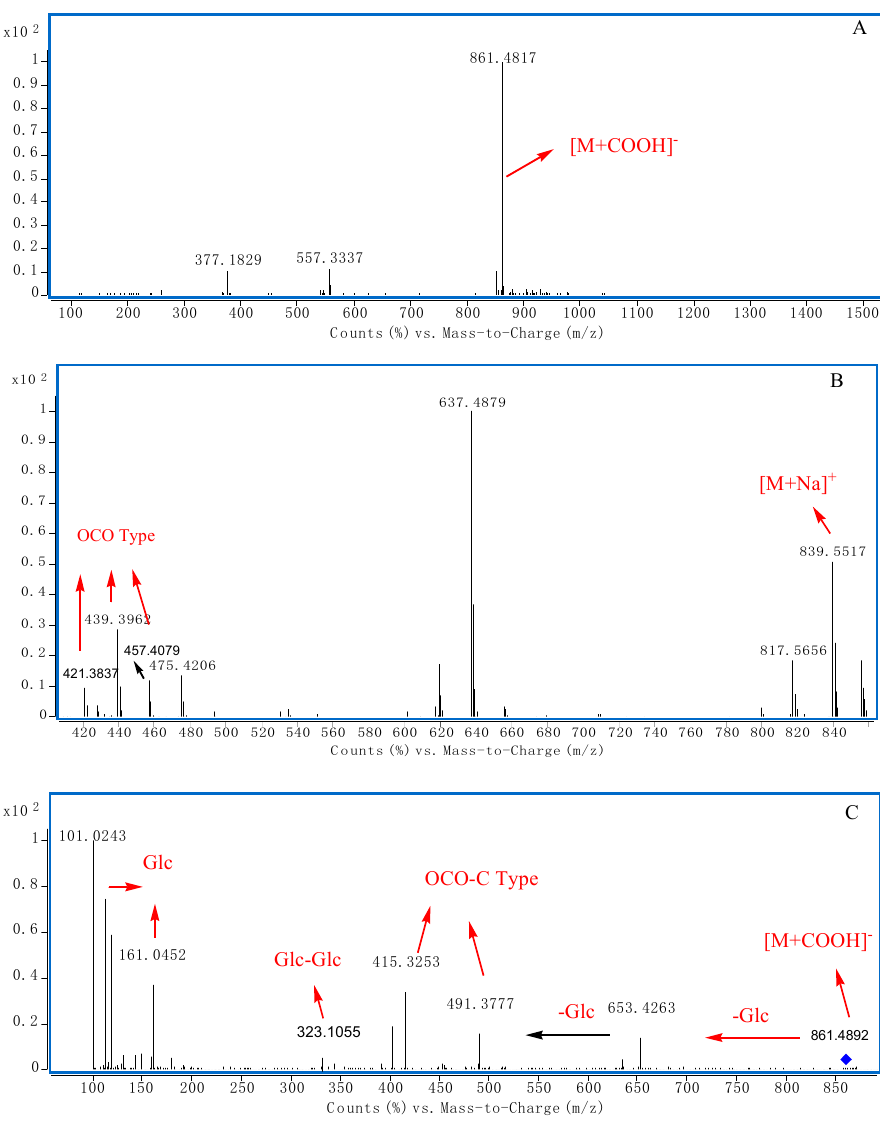
Figure 5. The typical TOF-MS spectra and fragmentation pathways of compound 9 . ( A ) MS spectrum in negative mode; ( B ) MS spectrum in positive mode; ( C ) MS/MS spectrum in negative mode. [M − H] − ( m/z 947.4713) and [M + COOH] − ( m/z 993.4633) of compound 64 were observed in the negative MS spectrum, and the peak ratio of [M − H] − to [M + COOH] − was 0.25. Diagnostic fragment ions at m/z 815.3567 [M − H − 132] − , 653.3778 [M − H − 132 − 162] − , 491.3608 [M − H − 132 − 162 − 162] − ,